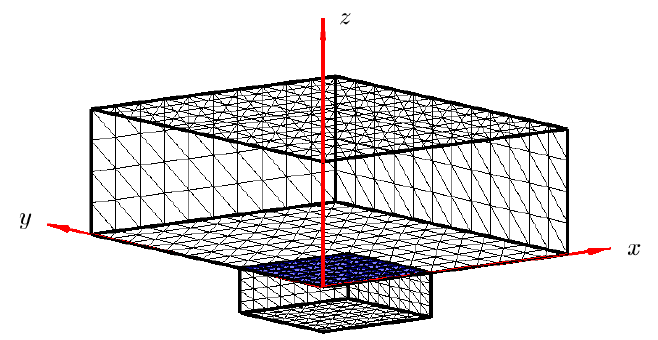
Figure 8. Microelectronic packaging boundary BEM mesh